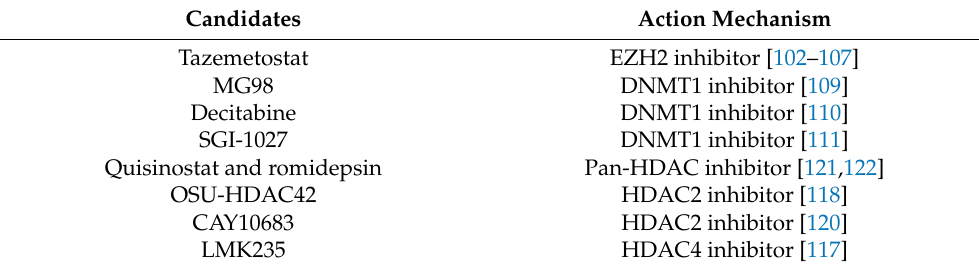
Table 2. The potent therapeutic efficacy against skin